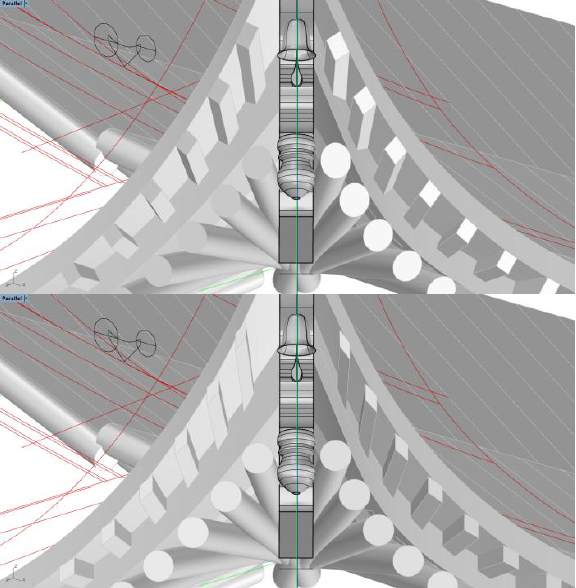
Figure 22. Comparison of different methods of “flying” rafters